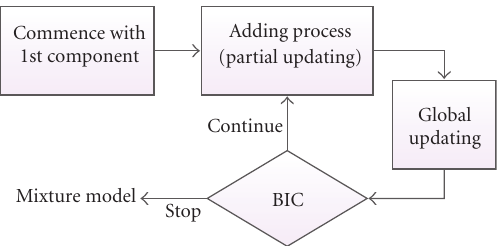
Figure 3: Block diagram of learning GMM using adapted BML technique.